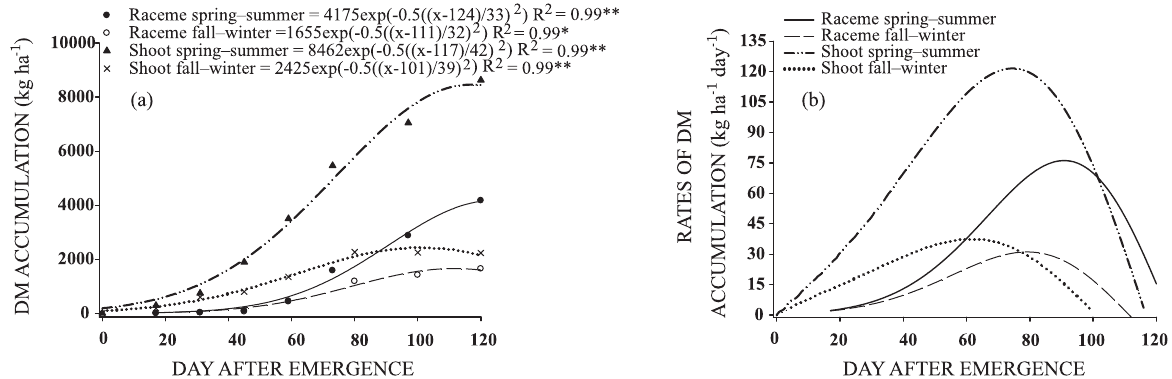
Figure 2. dry mater (dM) accumulation in racemes and shoot (a), and dM accumulation rates in racemes and shoot (b) of the castor bean hybrid Lyra in the 2005/2006 spring-summer and 2006 fall-winter growing seasons. ** and * are: significant at p ≤ 0.01 and p ≤ 0.05 by the F